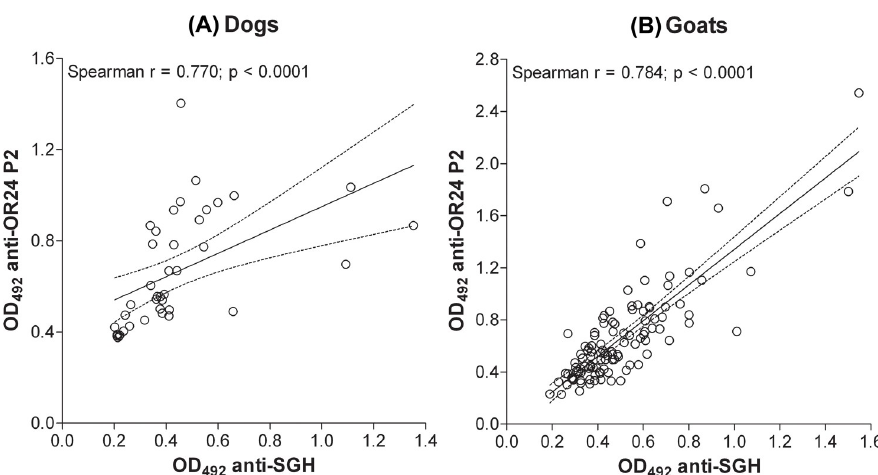
Fig 3. Correlation analyses between anti- P . orientalis IgG detected by SGH and by peptide OR24 P2 in ELISAs. For dogs (n = 40) and goats (n = 109) the peptide with the highest statistical values is displayed. Correlation coefficients and p-values from Spearman-Rank analysis are